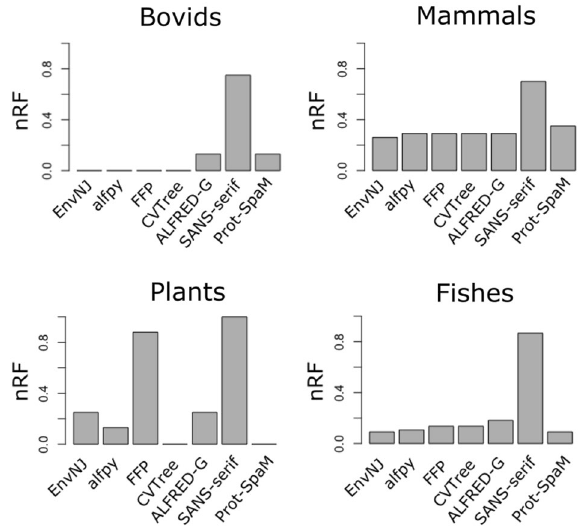
Figure 5. Summary of the performance of different programs with different data sets. Four sets of sequences were analyzed with the programs EnvNJ, alfpy, FFP, CVTree, ALFRED-G, SANS-serif and Prot-SpaM, using different parameters combinations. The perform of each method, in terms of nRF distances to the reference tree is given in Table 1 for the bovid group, Table 2 for the group of mammals, Table 4 for the plant species and Figure S1 for the fish species. This figure summarizes and shows the results that each program yielded with the optimal selection of